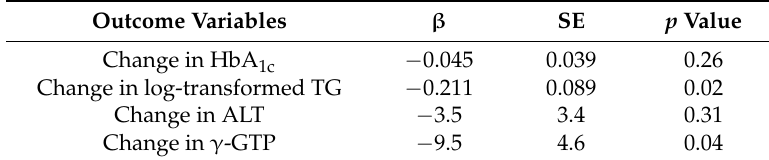
Table 3. The multiple linear regression analyses on the associations of PPAR- δ A/G SNP (rs2267668) with the changes in the four clinical